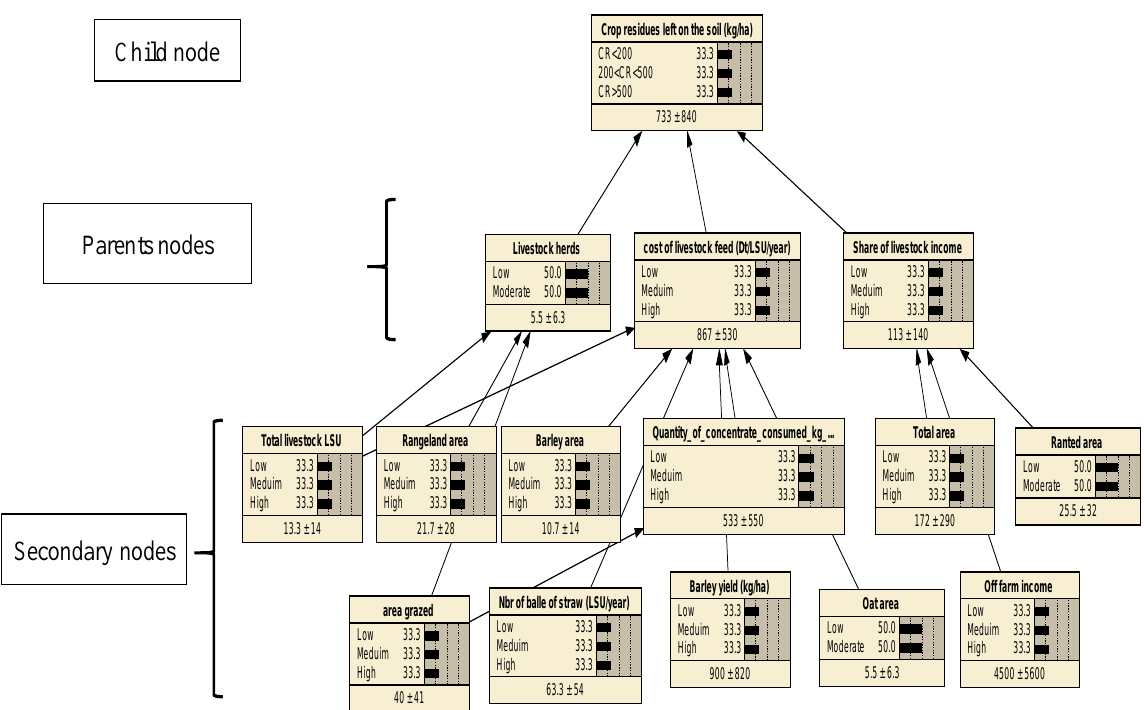
Figure 2. Conceptualization of a BBN structure diagram developed around a selected priority issue.